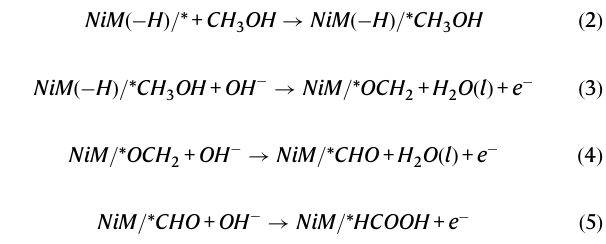
Fig. 5 | MOR mechanism revealed by experiment and DFT calculation. a Reaction scheme for the overall MOR on NiM-LDHs (M=Mn, Fe). The blue and yellow arrows indicate the proton-transfers during the precatalytic oxidation pro- cess and that associated with the reduction of NiM(-H) to NiM during the catalytic MOR process. The hydrogens of methanol or derived from methanol are high- lighted in yellow. Gibbs free energy diagrams for the b precatalytic process and